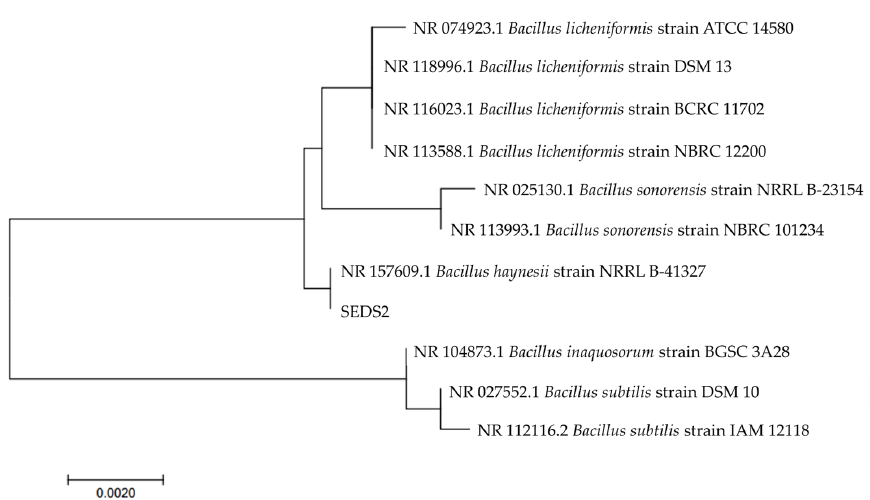
Figure 1. Phylogenetic tree of the strain SEDS2 and related strains based on neighbour-joining method using 16S rRNA sequences.